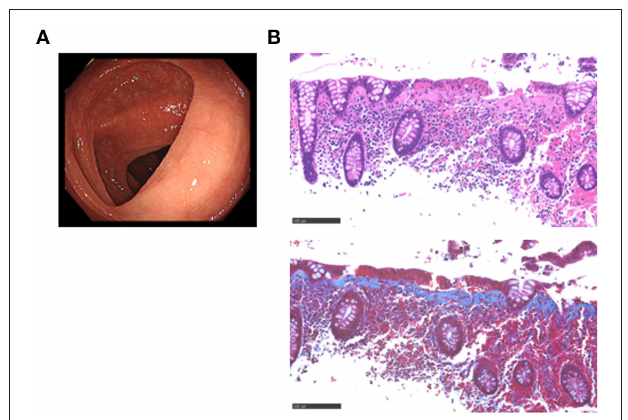
FIGURE 1 | Endoscopic and pathological findings in a patient with collagenous colitis in the active phase. (A) Colonoscopic examination revealed vascular networks without mucosal edema in the transverse colon. (B) Pathological examinations of the transverse colon biopsy samples revealed the presence of a subepithelial collagen band with a thickness > 10 µ m (Masson’s trichrome staining, bottom) and massive accumulation of immune cells in the lamina propria (hematoxylin and eosin, H&E staining, top). Scale bar, 100 µ m. Magnification ×